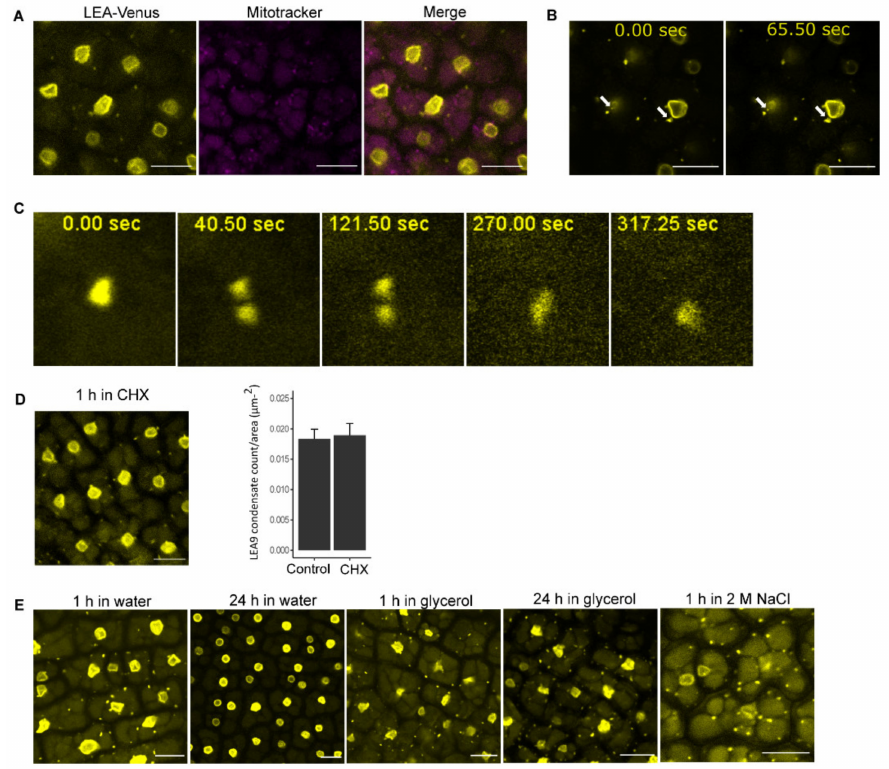
Figure 2. Cytoplasmic condensates of embryos of dry seeds from proLEA9::LEA9:Venus line. ( A ) Cytoplasmic condensates did not overlap with mitochondria by staining dissected embryos from seeds submerged in water for 1 h with Mitotracker. ( B ) Slight movement of cytoplasmic condensates as indicated by white arrows. ( C ) Division and fusion of cytoplasmic condensates. ( D ) Cytoplasmic condensate persistence after seeds were submerged in 1 mg/mL cycloheximide solution for 1 h. The bar plot shows counts of LEA9 condensates in seeds submerged in water or cycloheximide for 1 h ( n = 9). ( E ) Observation of cytoplasmic condensates in dry seeds after imbibition in different conditions. Bars indicate 10 µ